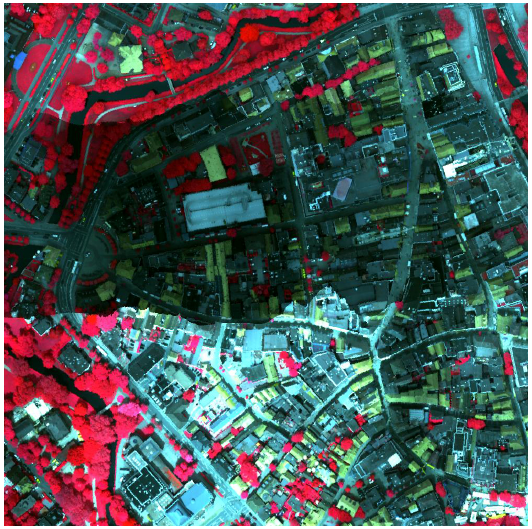
Figure 2: A 500 m x 500 m subset of the preprocessed CIR reflectance image of the hyperspectral scanner AISA+. The spatial resolution is 50